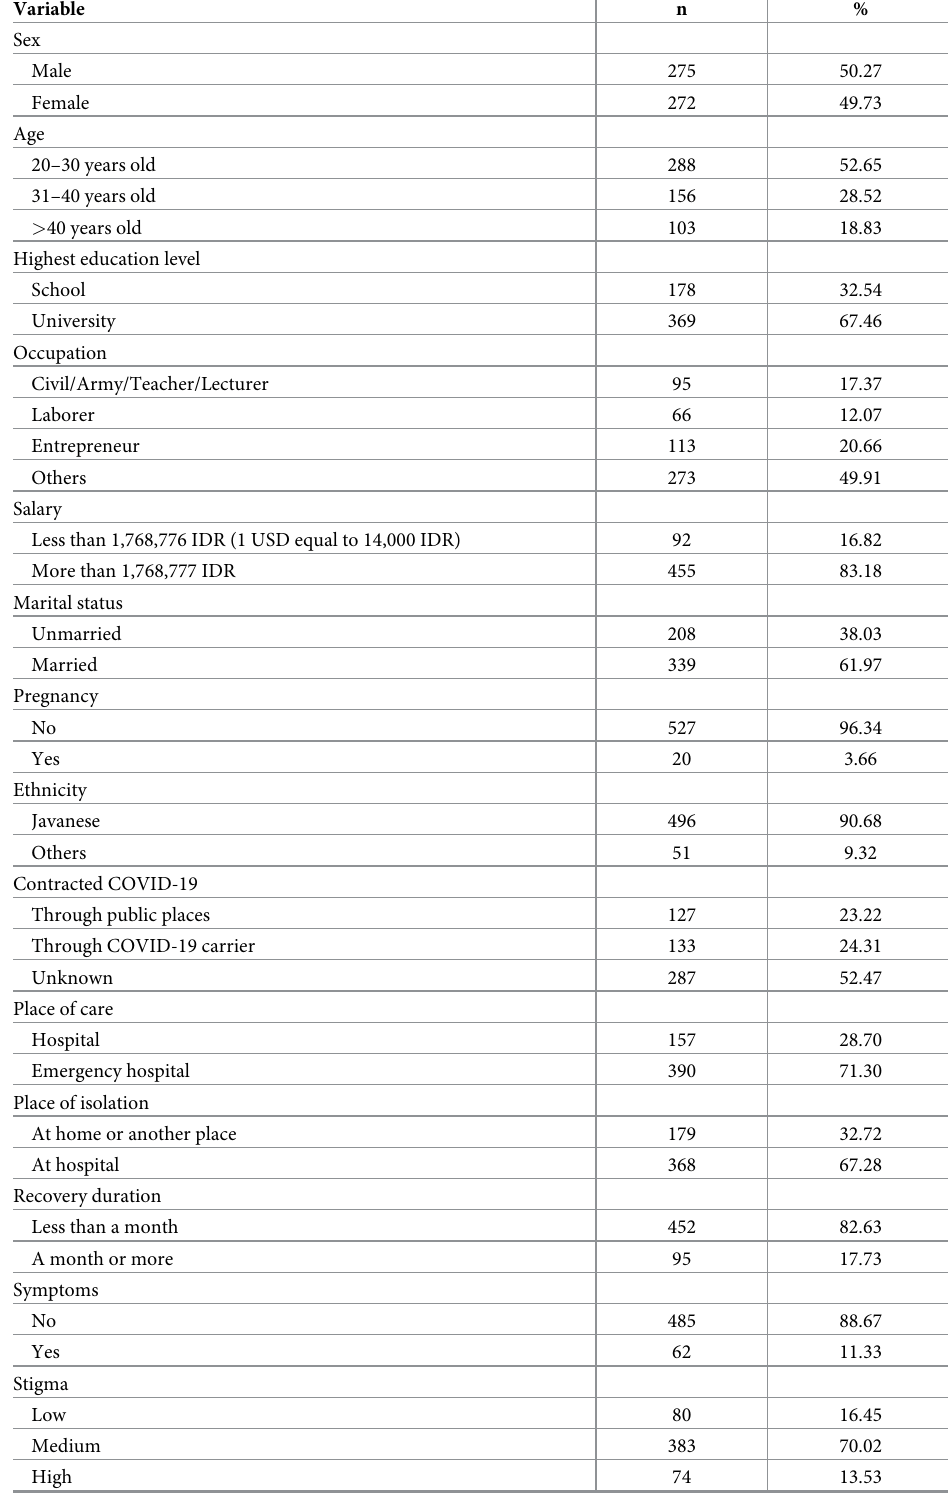
Table 1. Characteristics of respondents (n =